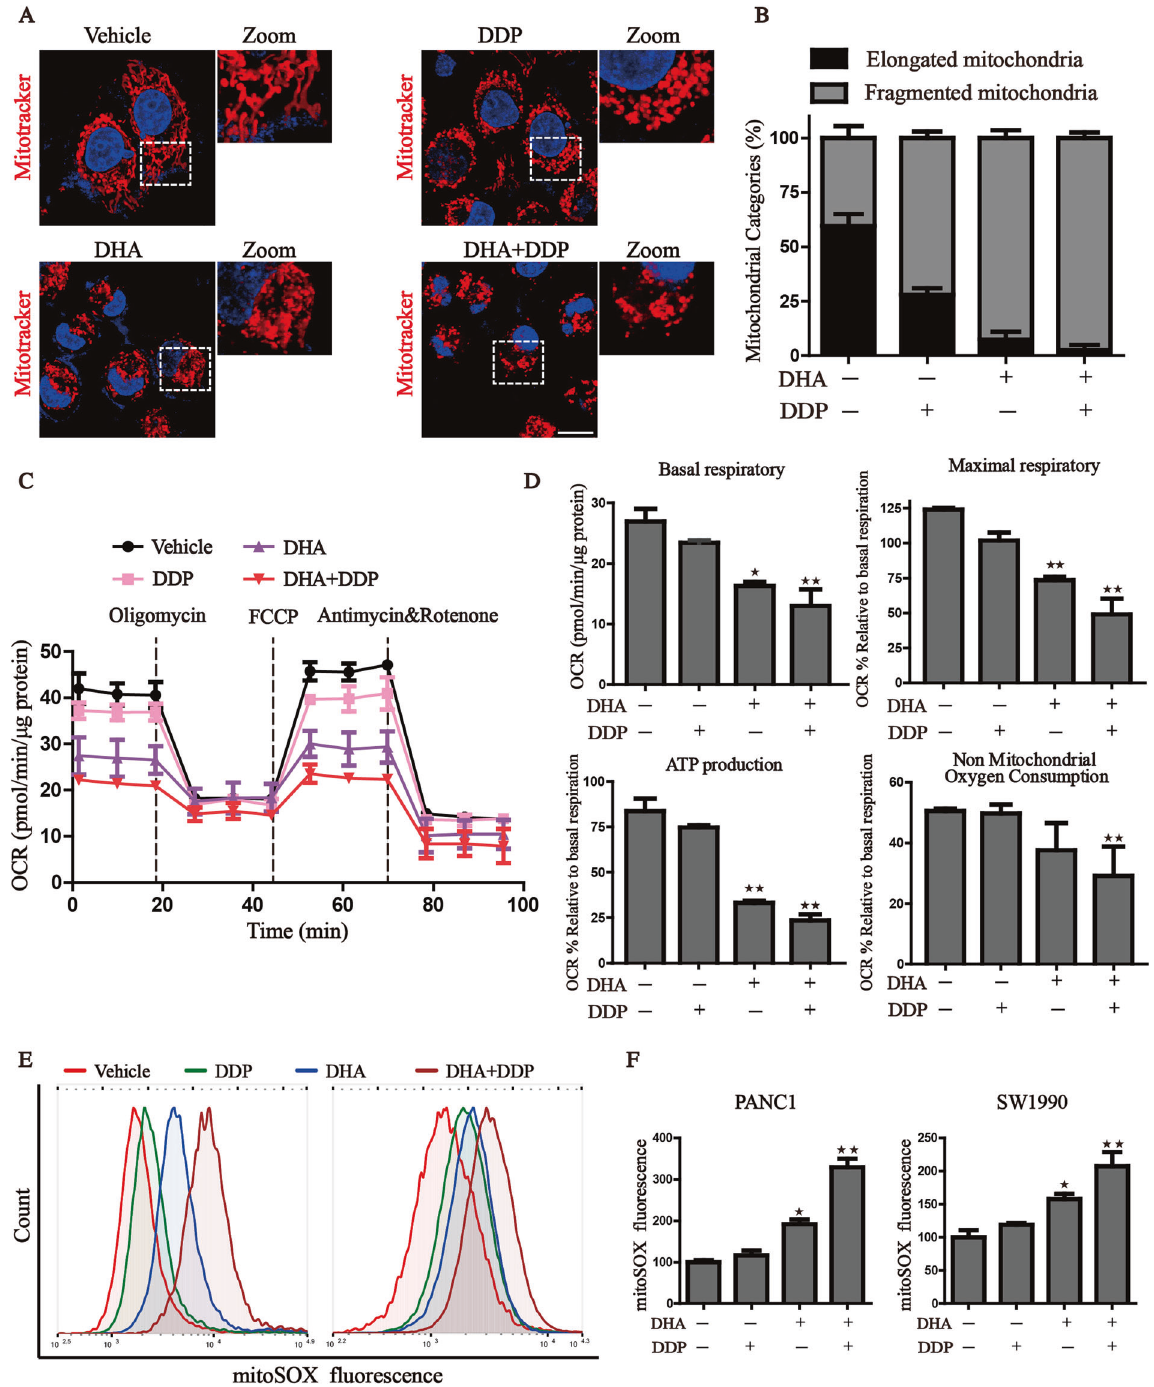
Fig. 3 DHA co-treatment with DDP synergistically impairs mitochondrial homeostasis. A , B Observation of the changes in mitochondrial morphology. The treated PANC1 cells were stained with MitoTracker probe (100 nM) and DAPI (10 μ g/mL) and then photographed by confocal laser microscope. Scale bars: 10 μ m. C , D Mitochondrial oxygen consumption rate (OCR) was carried out with a Seahorse analyzer after the sequential addition of oligomycin, FCCP, and Antimycin A/ Rotenone. The OCR values of maximal respiration, ATP and non-mitochondrial oxygen consumption were normalized to the basal respiration. E , F Flow cytometry was performed to measure mitochondrial ROS by mitoSOX probe (3 μ M) (values represented mean ± SD. ★ P < 0.05, ★★ P < 0.01 versus control). focused on mitochondrial morphology, which is an upstream Combined treatment of DHA and DDP synergistically impairs event of mitochondrial dysfunction. Following the administration mitochondrial homeostasis of DHA/DDP, the mitochondria became disorganized, smaller, and Given the links between DHA and mitochondrial dysfunction, we networks collapsed around the perinuclear region (Fig. 3A), which then tested whether DHA combined with DDP would amplify is more serious than the mono-treatment group. Statistical mitochondrial dysfunction in pancreatic cancer cells. We fi rst Cell Death and Disease (2021)